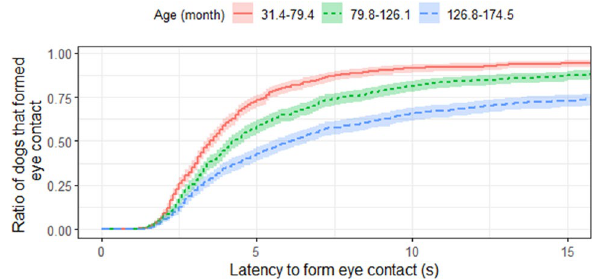
Figure 5. Survival plot for the 125 pet dogs divided into three age groups. Age was a continuous value in the analysis, but the sample was divided into three groups at the 0.33 and 0.67 quartiles for visualisation purposes only. For example, after 10 s elapsed, almost all dogs younger than 6 years (31.4–79.4 months) formed eye contact with the experimenter, while only circa 65% of the dogs older than 10 years (126.8–174.5 months) did so.